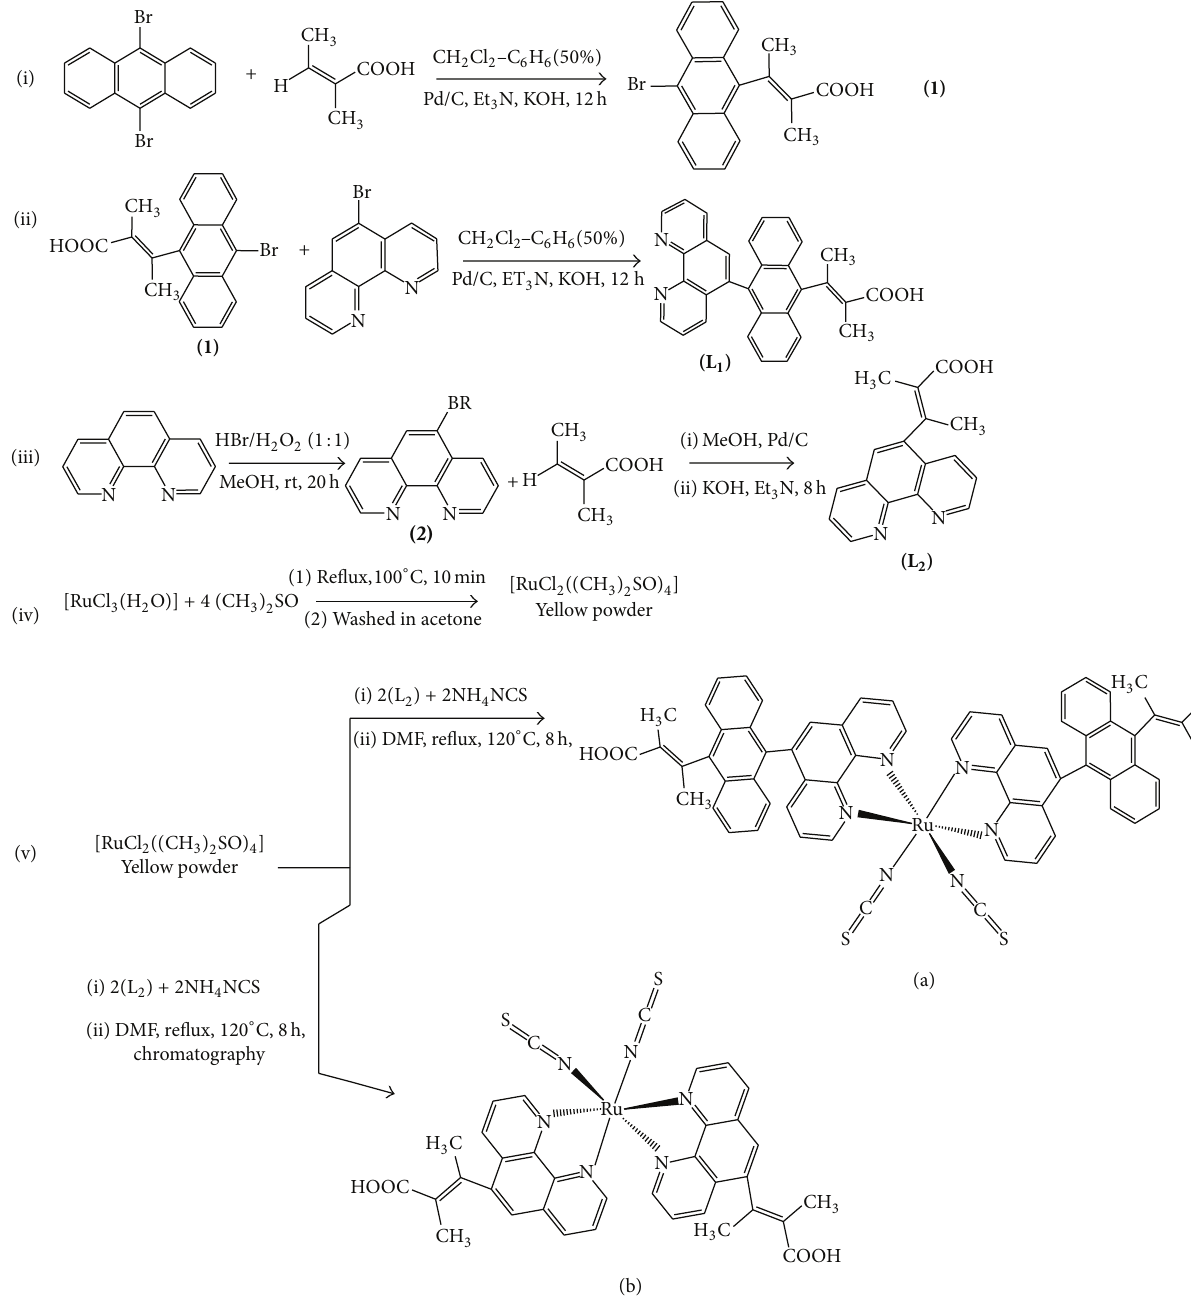
Scheme 1: Synthetic pathways for ligands L 1 and L 2 and complexes [Ru(L 1 ) 2 (NCS) 2 ] and [Ru(L 2 ) 2 (NCS) 2